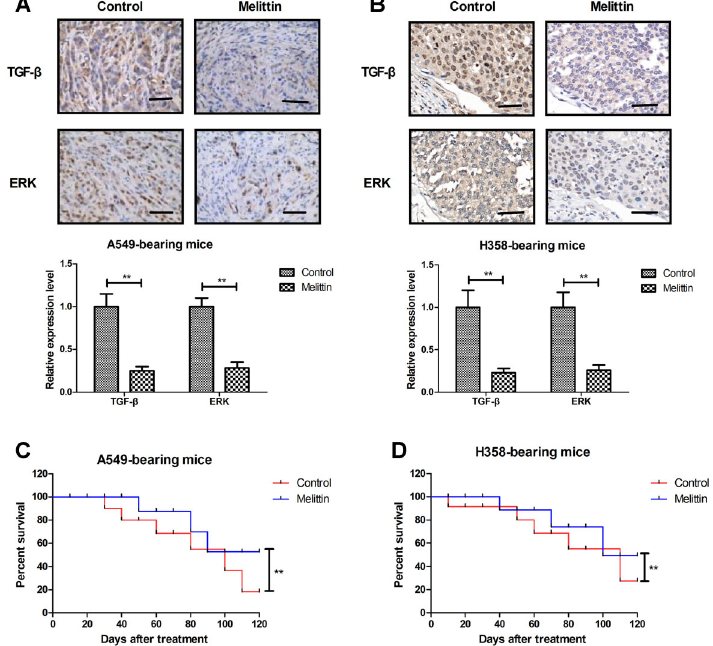
Figure 5. A and B , Effects of melittin on expression levels of tumor growth factor (TGF)- b and ERK in tumor tissues (scale bar: 50 m m). C and D , Melittin administration prolonged animal survival compared to PBS-treated mice in a 120-day observation. **P o 0.01 (Student ’ s t